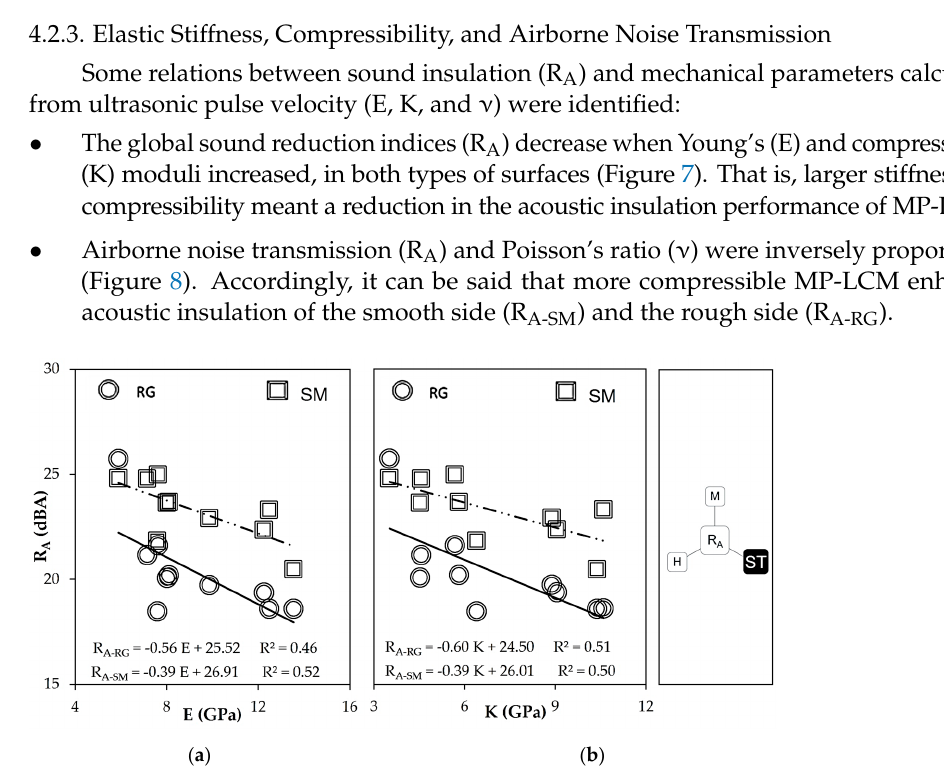
): ( a ) open porosity (P A